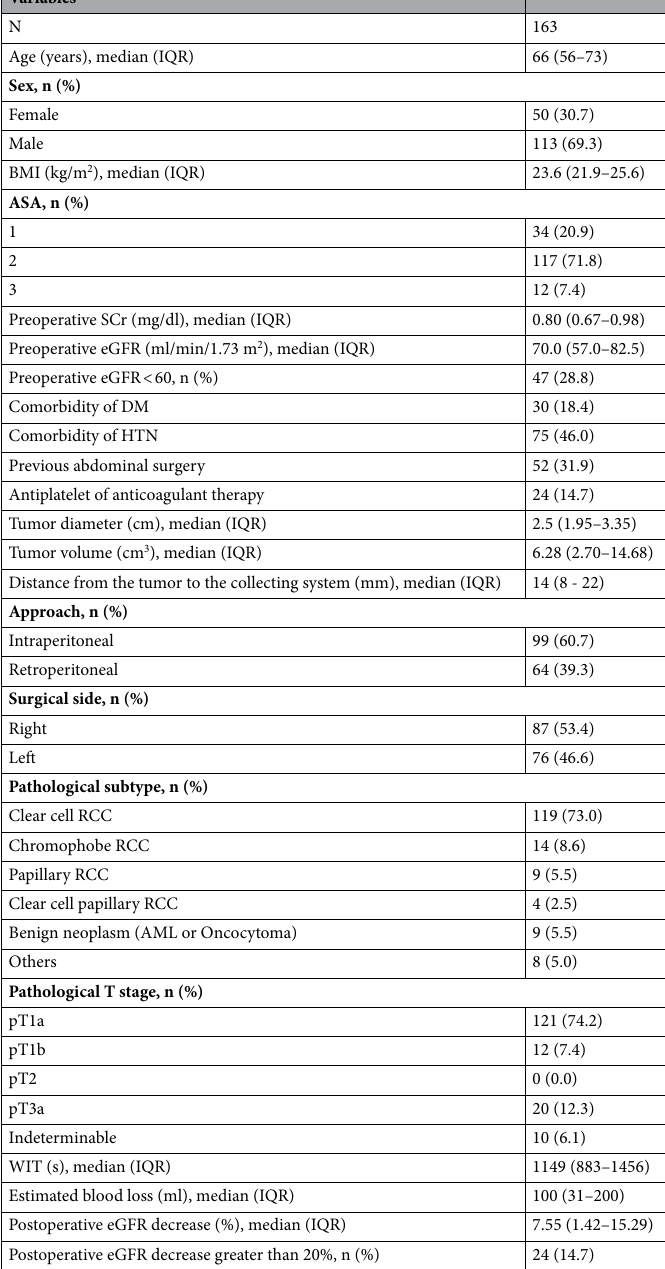
Table 1. Clinical patient characteristics. IQR interquartile range, BMI body mass index, ASA American Society of Anesthesiologists, SCr serum creatinine, eGFR estimated glomerular filtration rate, DM